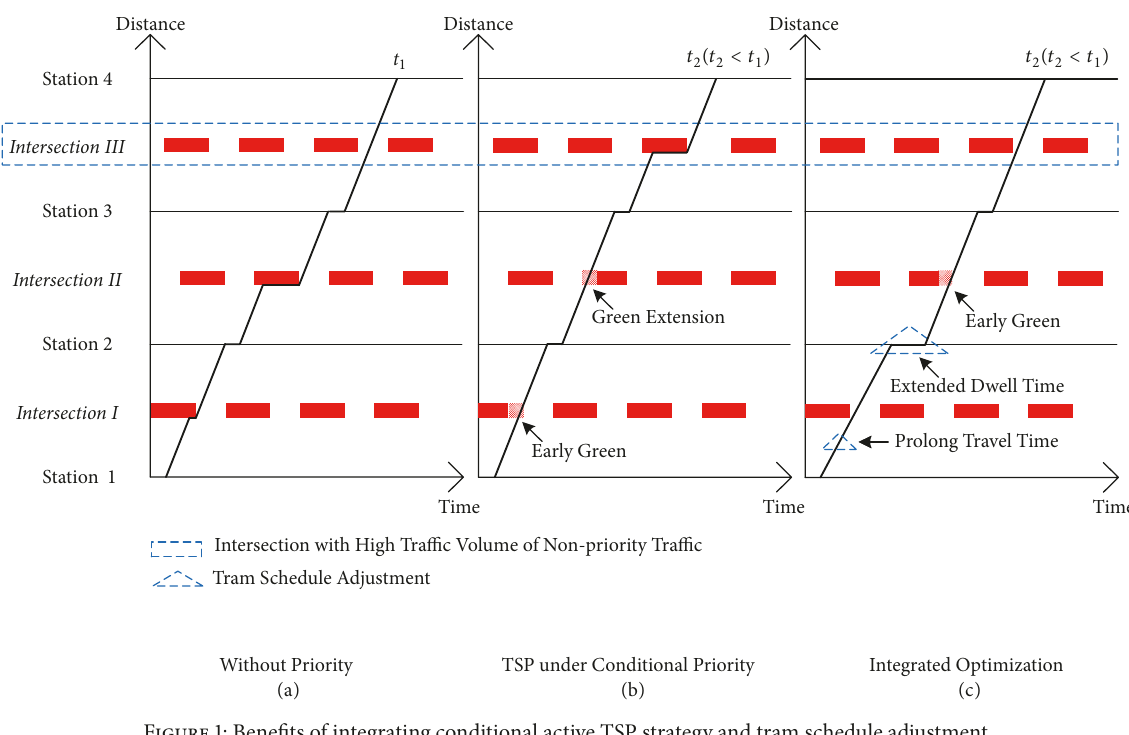
Figure 1: Benefits of integrating conditional active TSP strategy and tram schedule